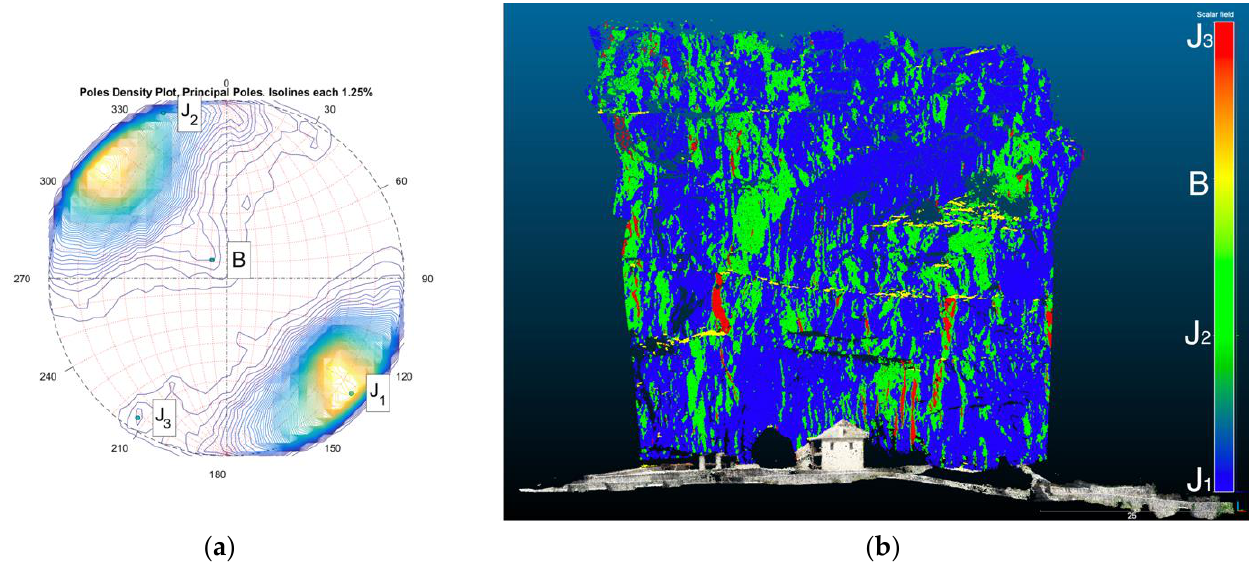
Figure 7. ( a ) Stereographic projections of the DSE-derived discontinuity sets for U2 and ( b ) the visual interpretation of the four (4) main sets in the 3D point cloud.